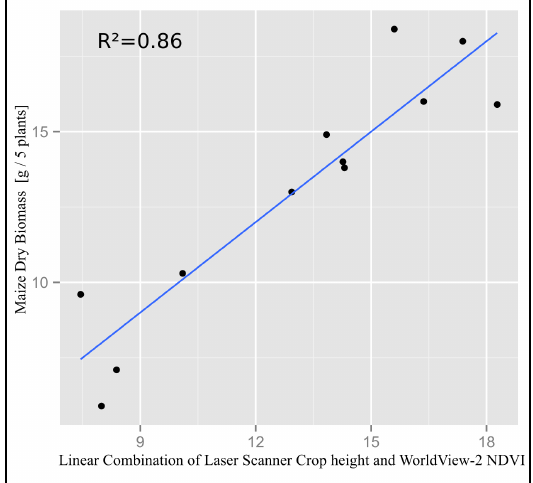
Fig. 10: Regression of the linear (best Fit) combination of CSM-derived plant height and NDVI (Bands 8+6) from WorldView-2 with the dry biomass.